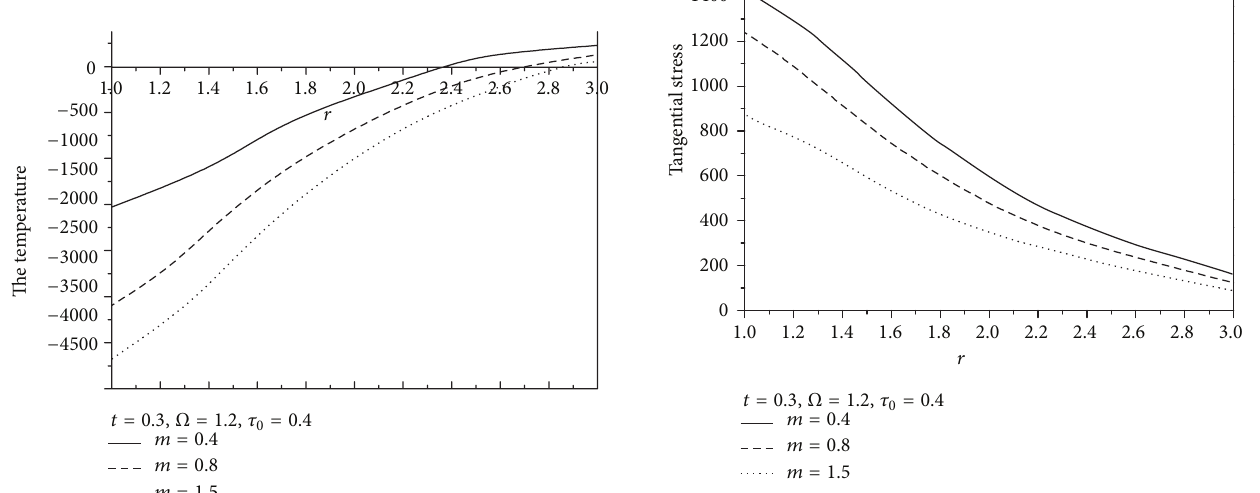
Figure 8: Variation of temperature 𝜃 with radius 𝑟 (thermoelastic nonhomogeneity medium).